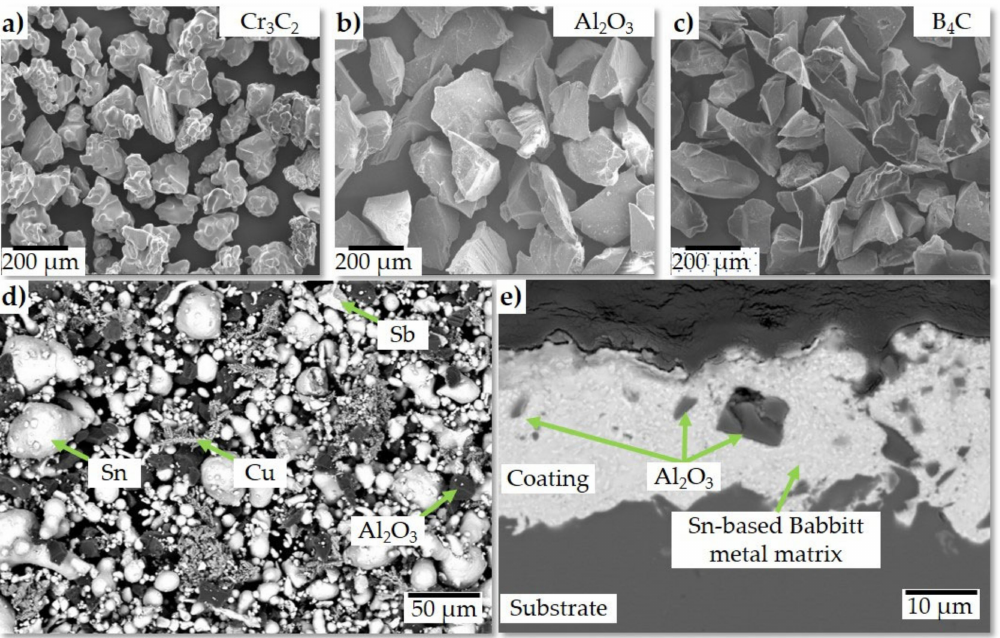
Figure 3. Scanning electron microscopic (SEM) images of the hard particle powders, blended powder, and the obtained coating: ( a ) Cr 3 C 2 , ( b ) Al 2 O 3 , and ( c ) B 4 C; ( d ) blended Sn-based Babbitt with Al 2 O 3 ; ( e ) Babbitt / Al 2 O 3 coating.